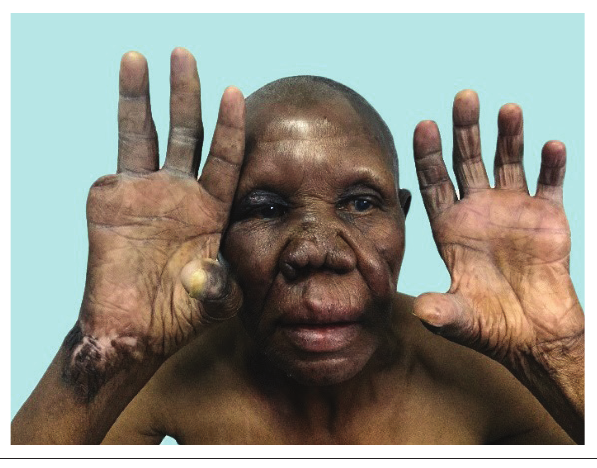
FIGURE 1: Debilitating complications of end-stage leprosy.